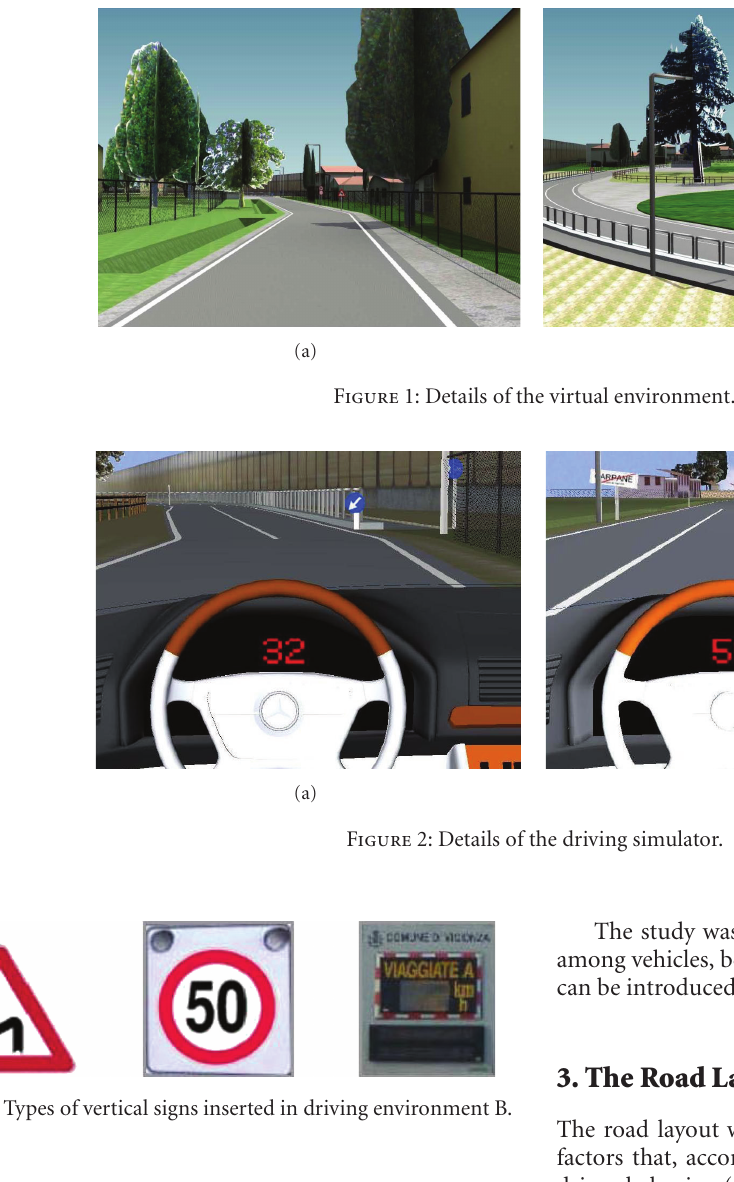
Table 1: Synopsis of di ff erent scenarios analysed during the